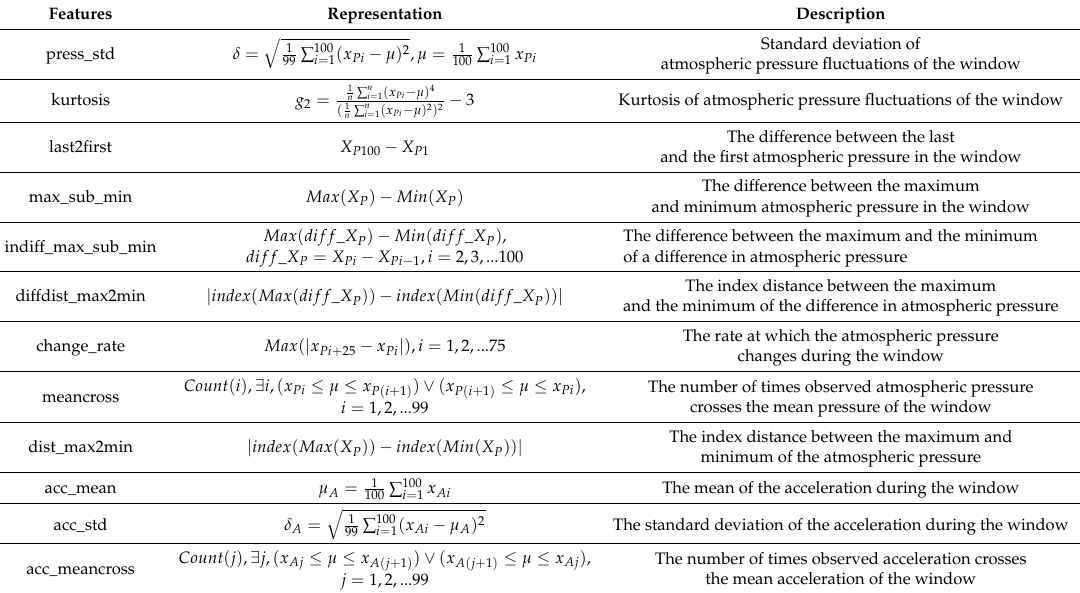
Table 1. Features used in the user context detection (UCD)